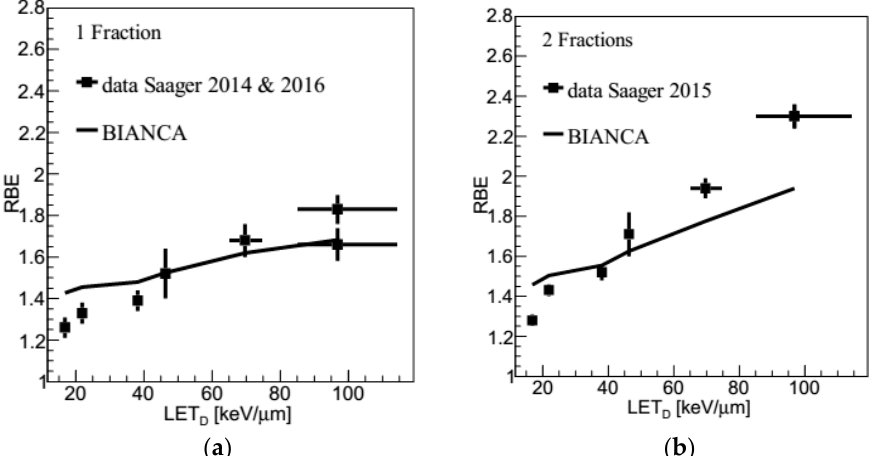
Figure 3. RBE as a function of dose-averaged LET for single-fraction (panel a ) or two-fraction (panel b ) irradiation of the rat spinal cord at di ff erent positions within the carbon-ion Spread-Out Bragg Peak (SOBP). The lines are predictions obtained by BIANCA, the points are experimental data taken from [12,14] (panel a ), or [13] (panel b ). In panel a, at 99 keV / µ m the higher experimental value is from a repetition experiment [14] and is considered as more reliable.